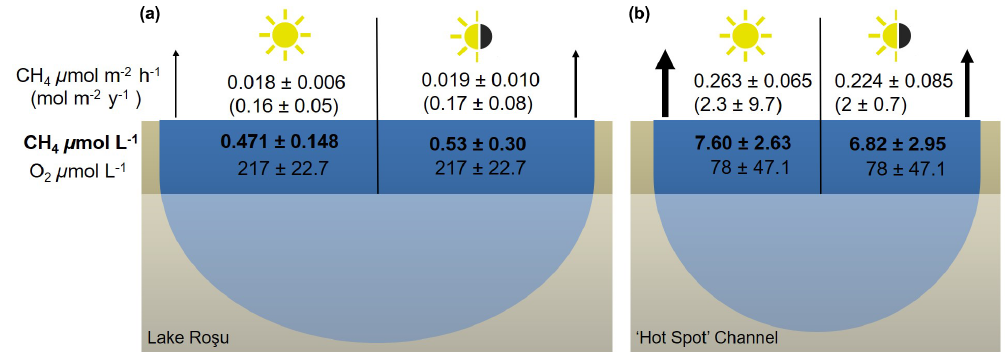
Figure 9. Mean methane fluxes on an hourly and annual basis as well as average concentrations of CH 4 and O 2 in Lake Ro¸su (a) and the hot spot channel (b) . The left half in each panel shows daylight data and the right half present 24h coverage (Fig. 8c). The thickness of arrows is a visual representation of the flux scale: the thicker the arrow the relatively larger the flux compared to the other